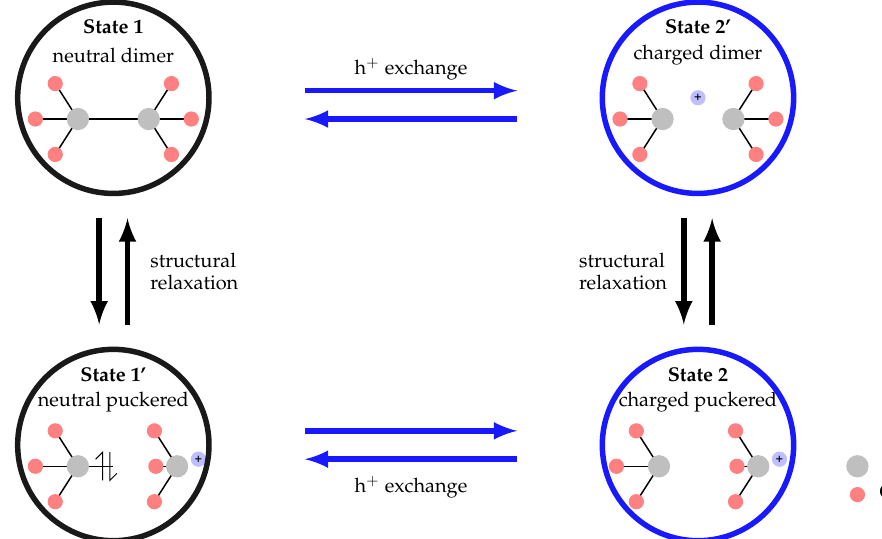
Figure 10. The non-radiative multiphonon (NMP) defect model has been proposed to explain the charge trapping kinetics of single defects. The model considers four defect states, two neutral defect states 1 and 1’ and two charged defect states 2’. The prime states are considered the meta-stable states of the system whereas the other states are the stable states. Either by exchanging a charge carrier or by structural relaxation the defect can charge its current state within in the NMP model. For a certain defect candidate, here shown for the E’ center, a certain atomic configuration of a defect can be assigned to one of the states of the defect